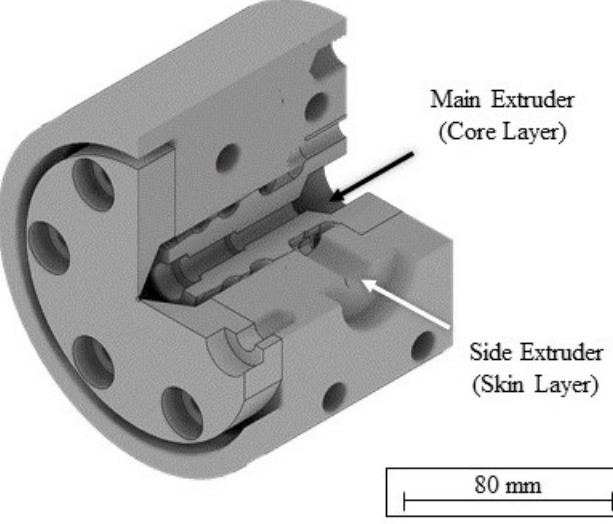
Figure 2. Coextrusion die based on a spiral mandrel die.